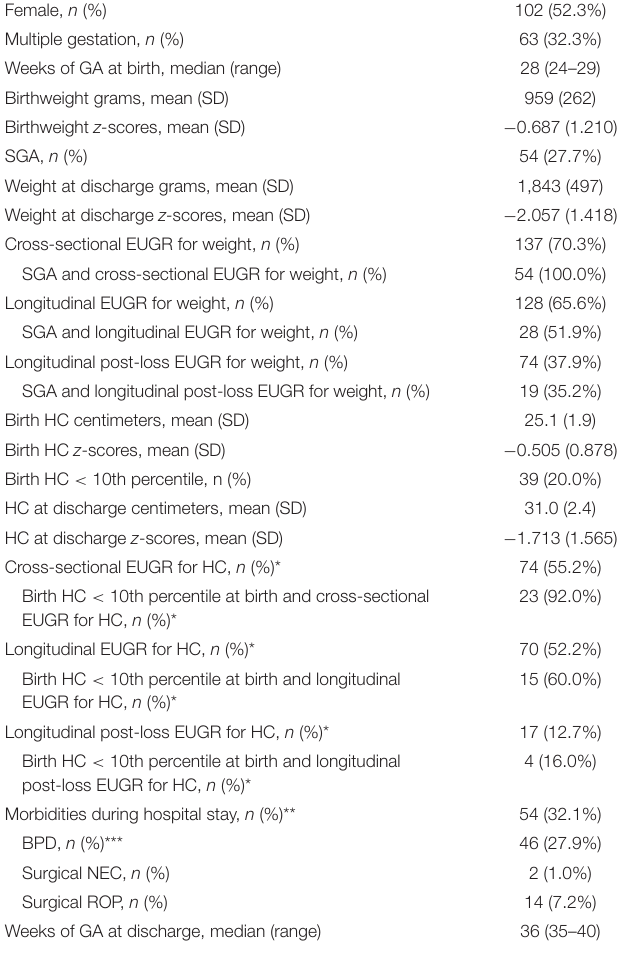
FIGURE 1 | Flowchart of inclusion and exclusion criteria.